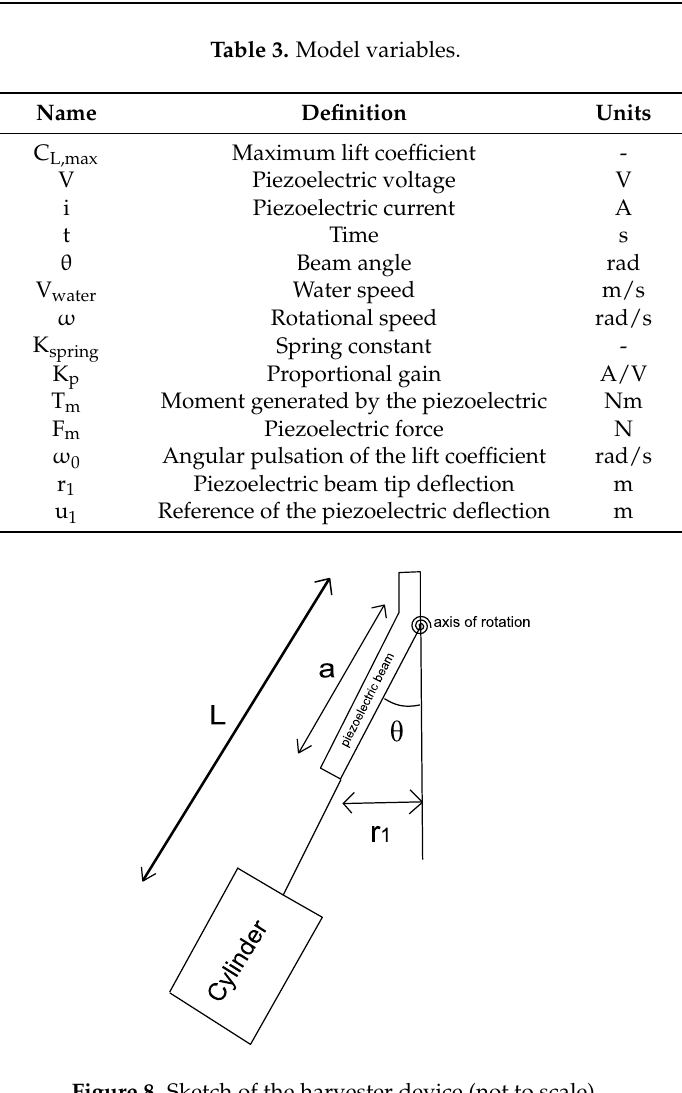
Figure 8. Sketch of the harvester device (not to scale).